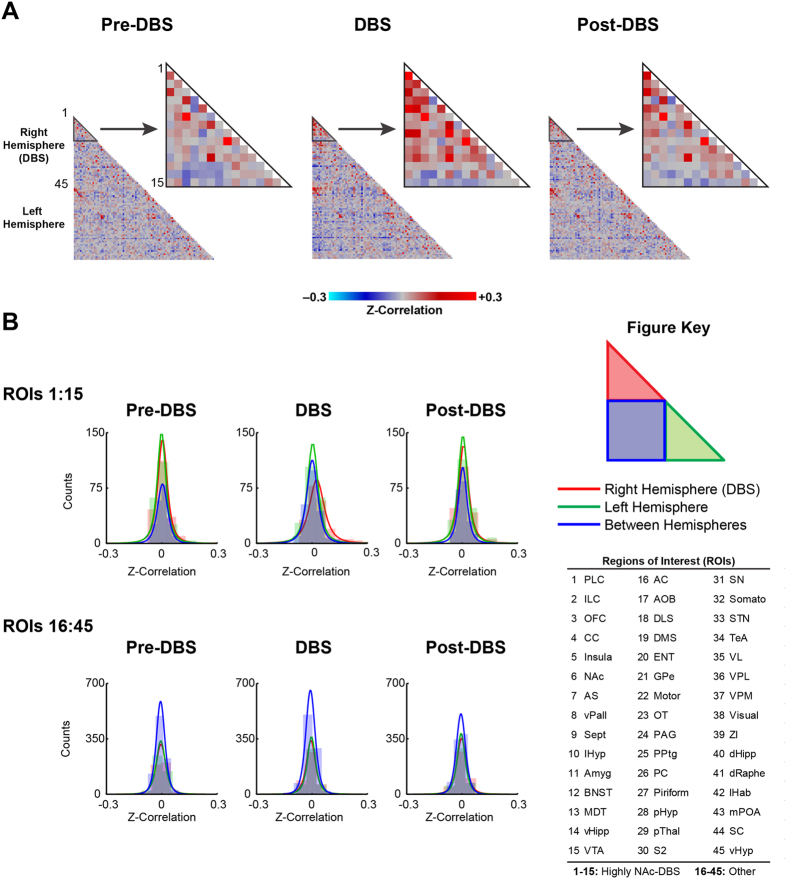
fcMRI modulation by 130 Hz NAc-DBS.(A) Mean correlation matrices (n = 7) for each stimulus condition (Pre-DBS, DBS, Post-DBS) using 45 regions-of-interest (ROIs, see Figure Key). ROIs were chosen a priori, with reference to anatomical regions described in a standard rat brain atlas35. Note the presence of between-hemispheric regional connectivity (displayed as a red diagonal line) in all matrices. (B) Histograms and t-distribution fits for each stimulus condition, network (NAc-DBS [ROIs #s 1–15] and Other [ROIs #’s 16–45]) and connectivity grouping (within and between hemispheres) using correlation measures from the average correlation matrices. Abbreviations: PLC: Prelimbic Cortex; ILC: Infralimbic Cortex; OFC: Orbitofrontal Cortex; CC: Cingulate Cortex; Insula: Insular Cortex; NAc: Nucleus Accumbens; AS; Anterior Striatum; vPAll: Ventral Pallidum; Sept: Septum; lHyp: Lateral Hypothalamus; Amyg: Amygdala; BNST: Bed Nucleus of the Stria Terminalis; MDT: Mediodorsal Thalamus; vHipp: Ventral Hippocampus; VTA: Ventral Tegmental Area; AC: Auditory Cortex; AOB: Accessory Olfactory Bulb; DLS: Dorsolateral Striatum; DMS: Dorsomedial Striatum; ENT: Entorhinal Cortex; GPe: External Globus Pallidus; Motor: Motor Cortex (Primary and Secondary); OT: Olfactory Tubercle; PAG: Periaqueductal Grey; PPTg: Pedunculopontine Tegmental Nucleus; PC: Parietal Cortex; Piriform: Piriform Cortex; pHyp: Posterior Hypothalamus; pThal: Posterior Thalamus; S2: Secondary Somatosensory Cortex; SN: Substantia Nigra; Somato: Primary Somatosensory Cortex; STN: Subthalamic Nucleus; TeA: Temporal Association Cortex; VL: Ventrolateral Thalamus; VPL: Ventral Posterolateral Thalamus; Visual: Visual Cortex (Primary and Secondary); ZI: Zona Incerta; dHipp: Dorsal Hippocampus; dRaphe: Dorsal Raphe Nucleus; lHab: Lateral Habenula; mPOA: Medial Preoptic Area; SC: Superior Colliculus; vHyp: Ventral Hypothalamus.